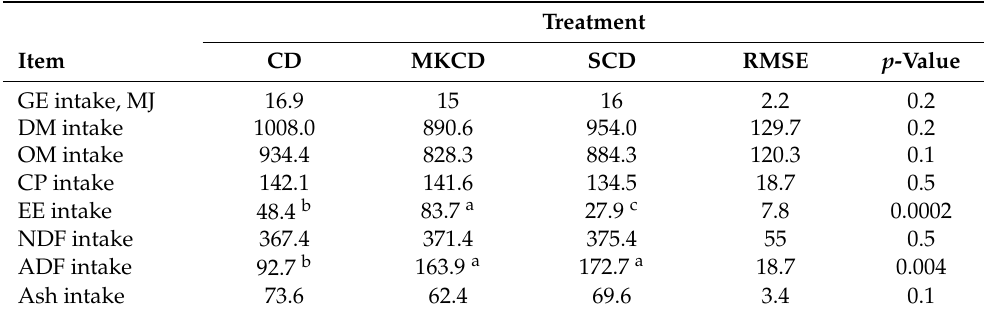
Table 3. Nutrient intake (g/day, unless stated differently) from the digestibility experiment (dry matter basis) of lambs.